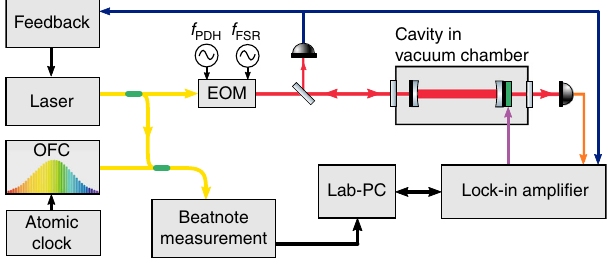
Fig. 10 Schematic layout of the NICE-OHMS experimental setup. The EOM (electro-optic modulator) is double modulated at both frequencies f f PDH and FSR , which are 20 and 305 MHz, respectively, where the latter is exactly matched to the cavity-free spectral range. OFC, an optical frequency comb laser. For further details, see